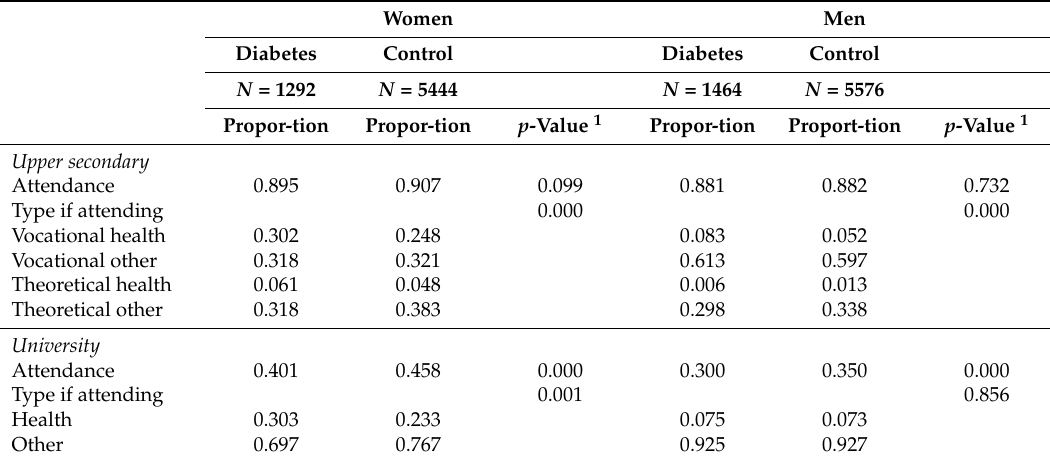
Table 1. Descriptive statistics of educational field at upper secondary school and university.